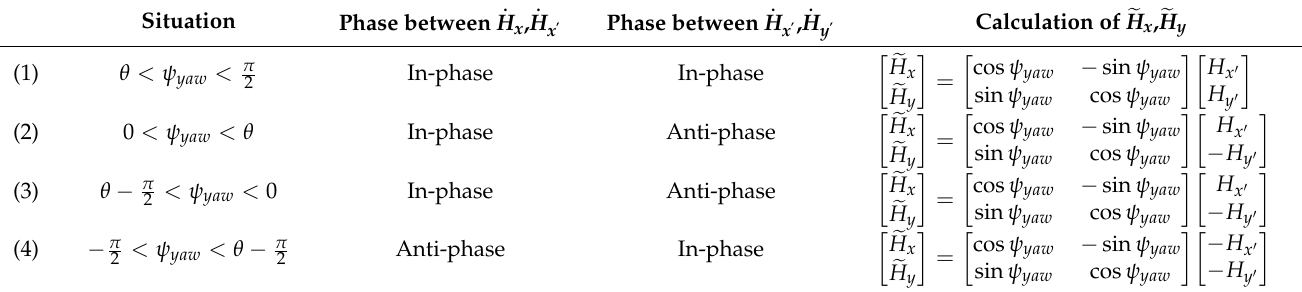
. . H x and H x (cid:48) , the phase between . . H x , H x